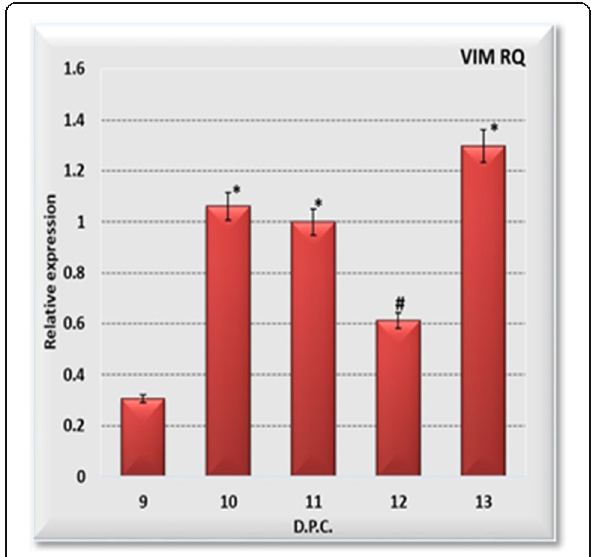
Fig. 3 Histogram representing the gene expression of Vimentin (VIM), at the embryonic stages E9.5 to E13.5 of rat embryos ( Rattus norvegicus ).* means significant against 13 D.P.C. group. P < 0.05